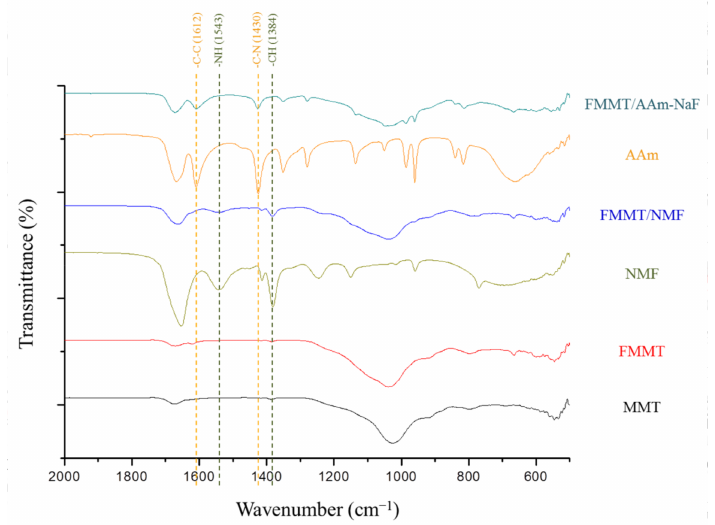
Figure 2. FTIR spectra (500–2000 cm − 1 ) of MMT, FMMT, NMF, FMMT-NMF, AAm, and FMMT-